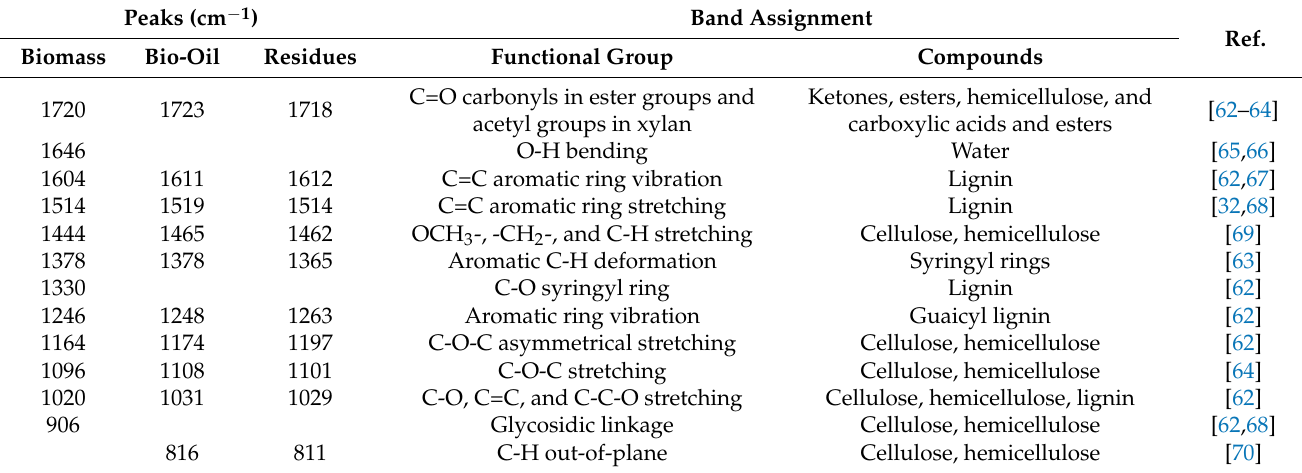
Table 5. FTIR-ATR relevant peaks for biomass, bio-oil, and solid